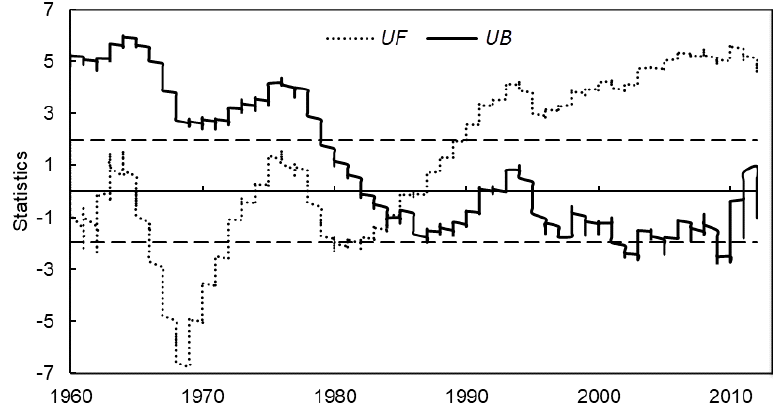
Figure 3. Change detection of runoff during 1960–2012 for the Qingliu River basin, China. UF and UB present the forward trend and backward trend line of the runoff series. UF >0 and UF <0 indicate the increasing trend and decreasing trend, respectively.